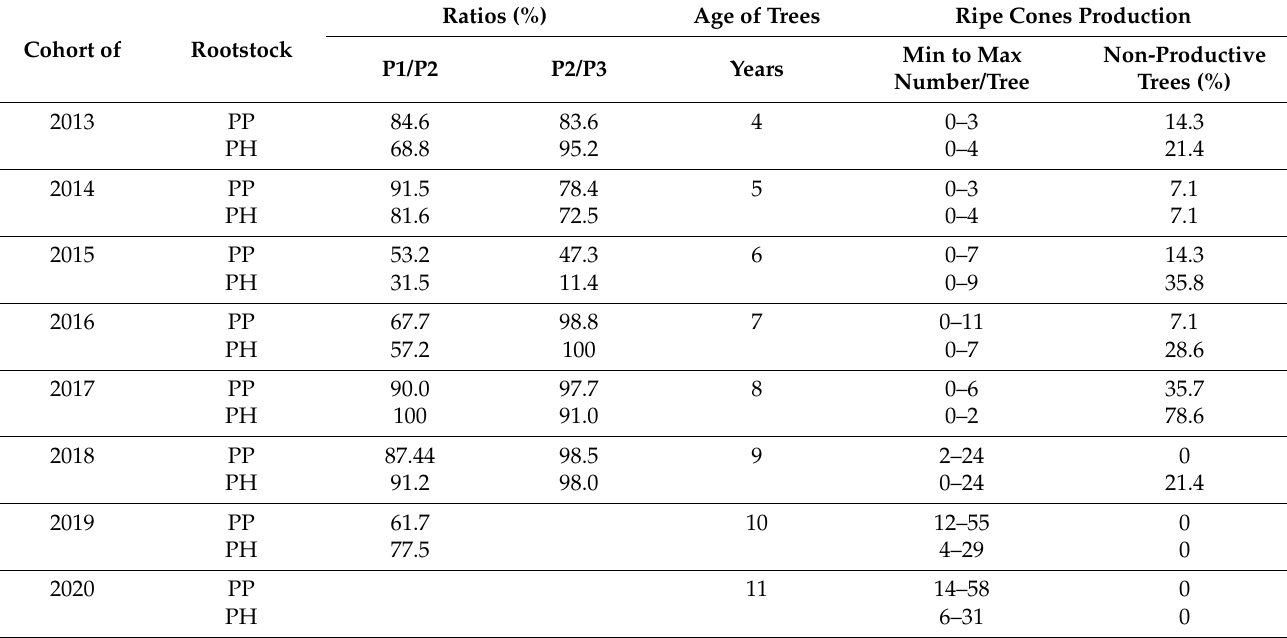
Table 2. Evolution of strobili to conelets and ripe cones. Heterogeneity in the production of the grafted trees evaluated in P. halepensis (PH) or in P. pinea (PP).